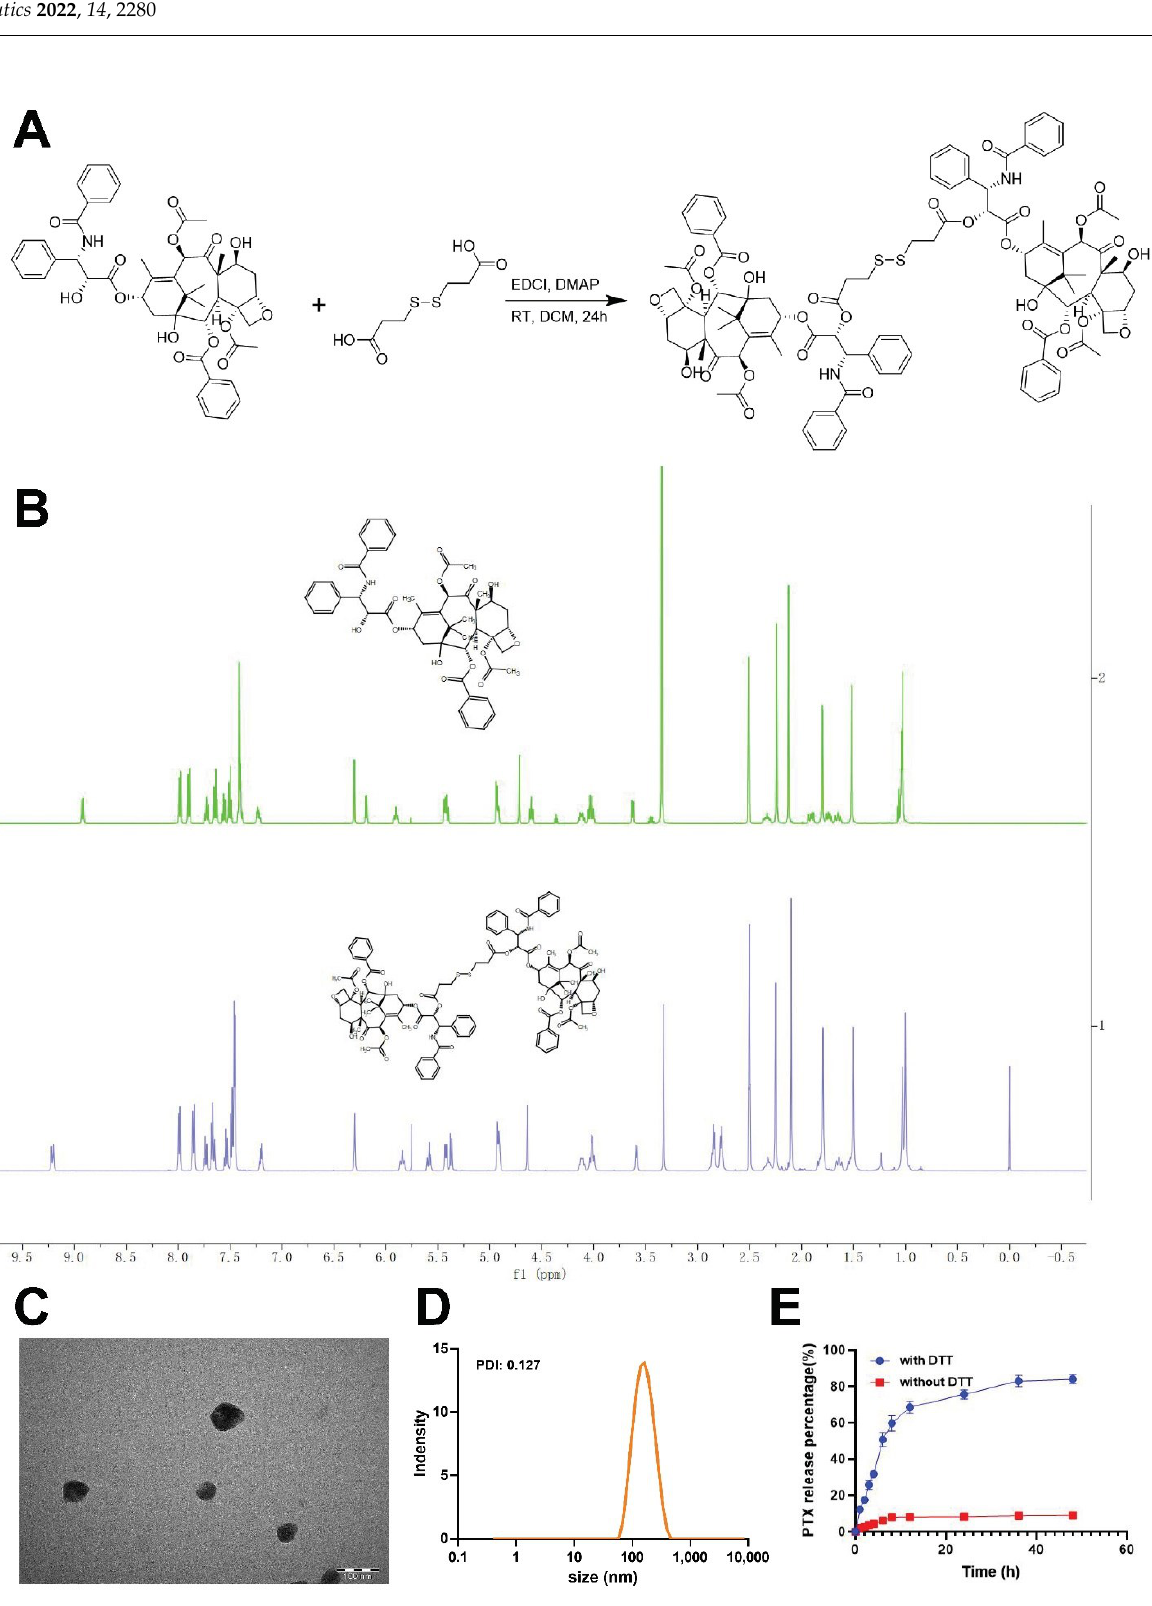
Figure 1. PTX-SS-PTX synthesis and characterization of TPG NPs. ( A ) The schematic of PTX-SS-PTX synthesis; ( B ) FTIR analyzing results of PTX and PTX-SS-PTX; TEM image ( C ) and dynamic light scattering ( D ) of TPG NPs (scale bar = 100 nm); ( E ) PTX release from TPG NPs in with/without DTT solutions (10 mM).